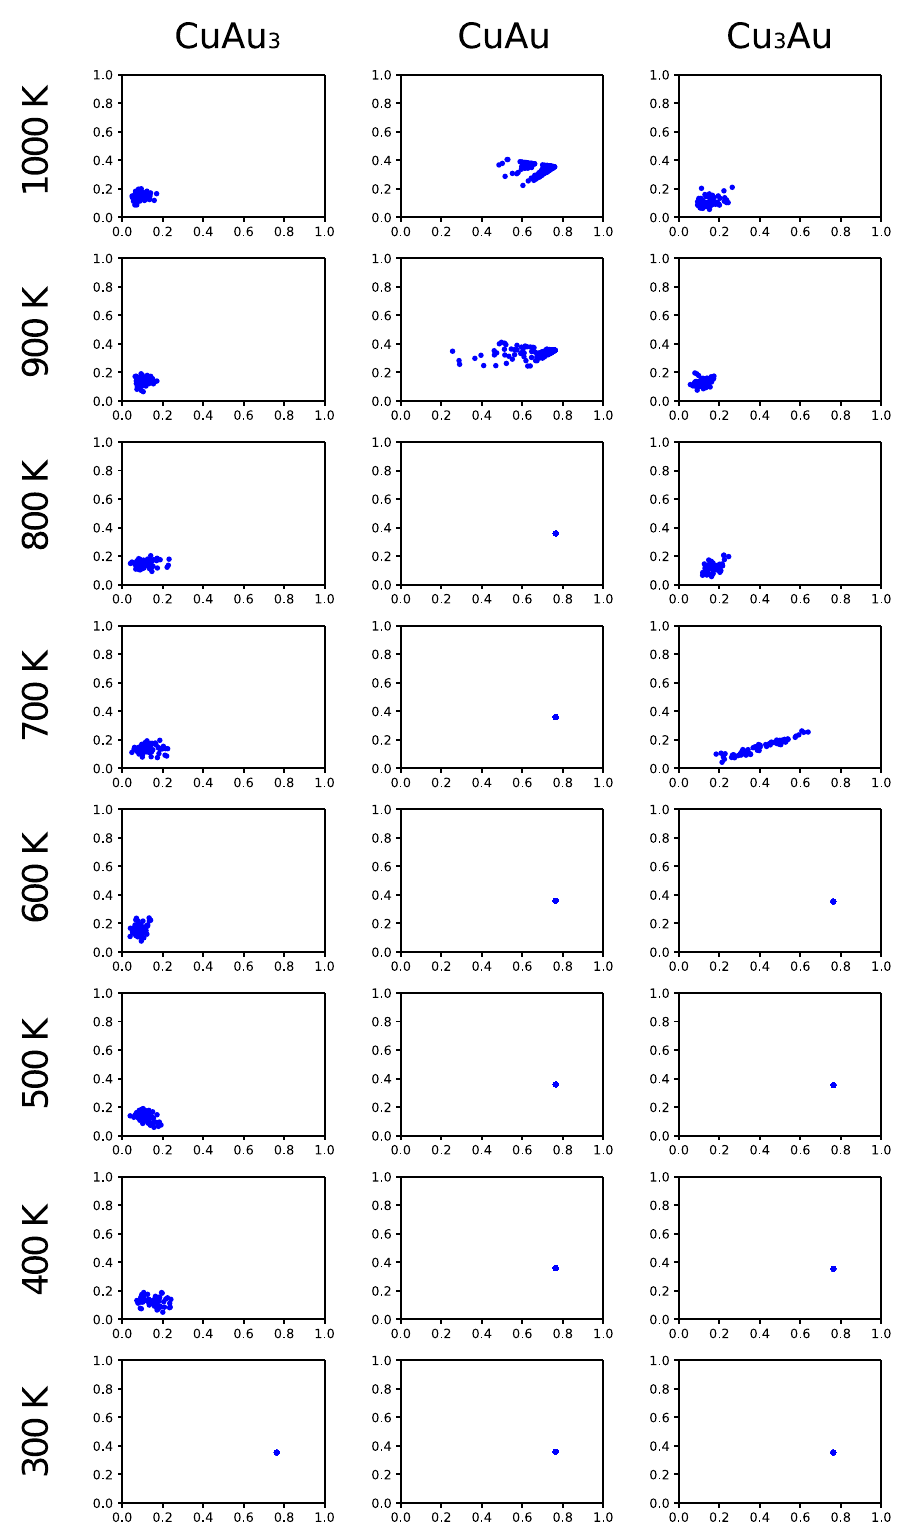
Fig. 3 Voronoi weighted Steinhardt parameters of CuAu 3 , CuAu, and Cu 3 Au. The ordinate and abscissa of each plot represent q4 and q6, respectively. These order parameters are calculated with respect to Cu in the case of CuAu 3 and CuAu, and with respect to Au in the case of Cu 3 Au. The disordered structures can be observed as the diffused points in the fi gures.